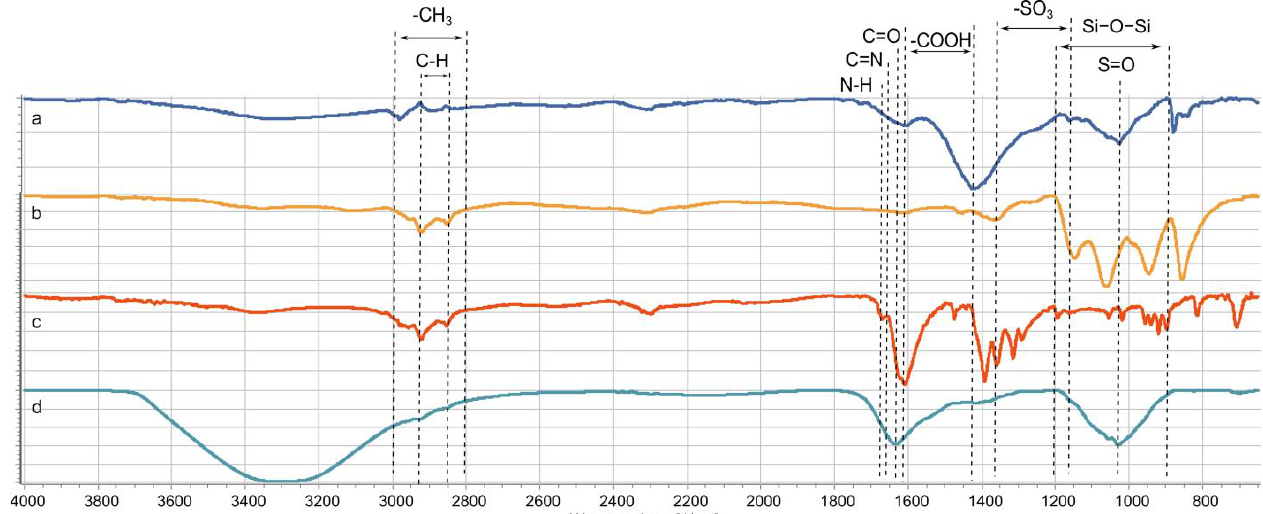
Figure 5. FTIR spectra of (a) Sargassum spp., (b) Fe 3 O 4 @ Sargassum , (c) Fe 3 O 4 @ Sargassum @EDTA, and